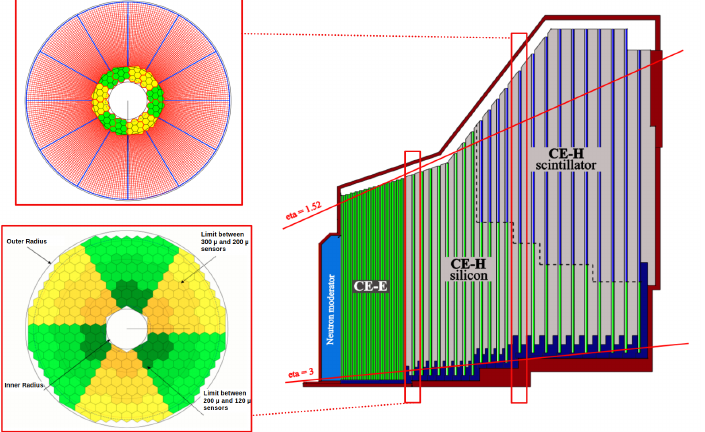
Figure 1. Schematic view of one HGCAL endcap slice ( right ), a representative hadronic calorimeter layer ( top left ), and electromagnetic calorimeter layer ( bottom left